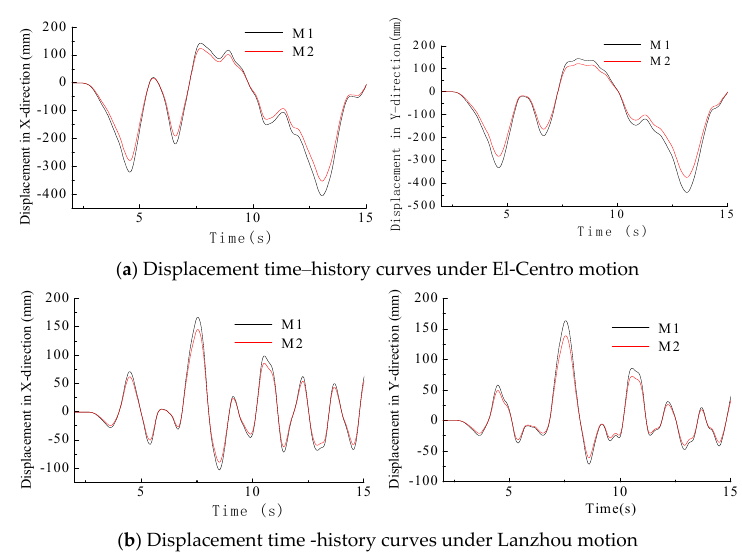
Figure 22. Time–history curves of displacement on the top floor.